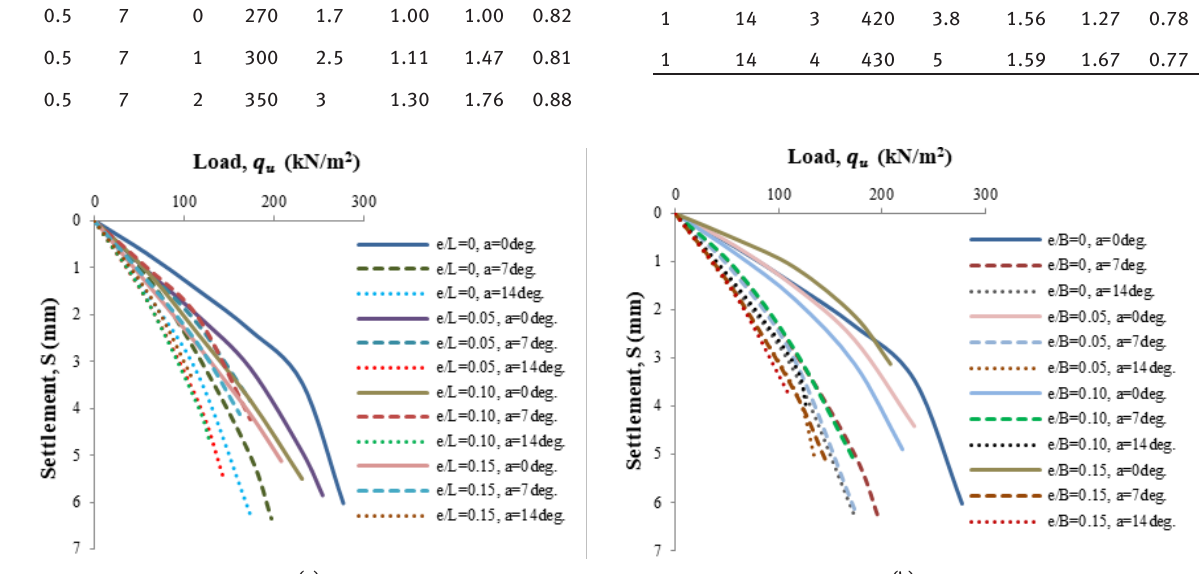
Figure 6(c): Variation of L–S curve for D dimension ( e/B ,